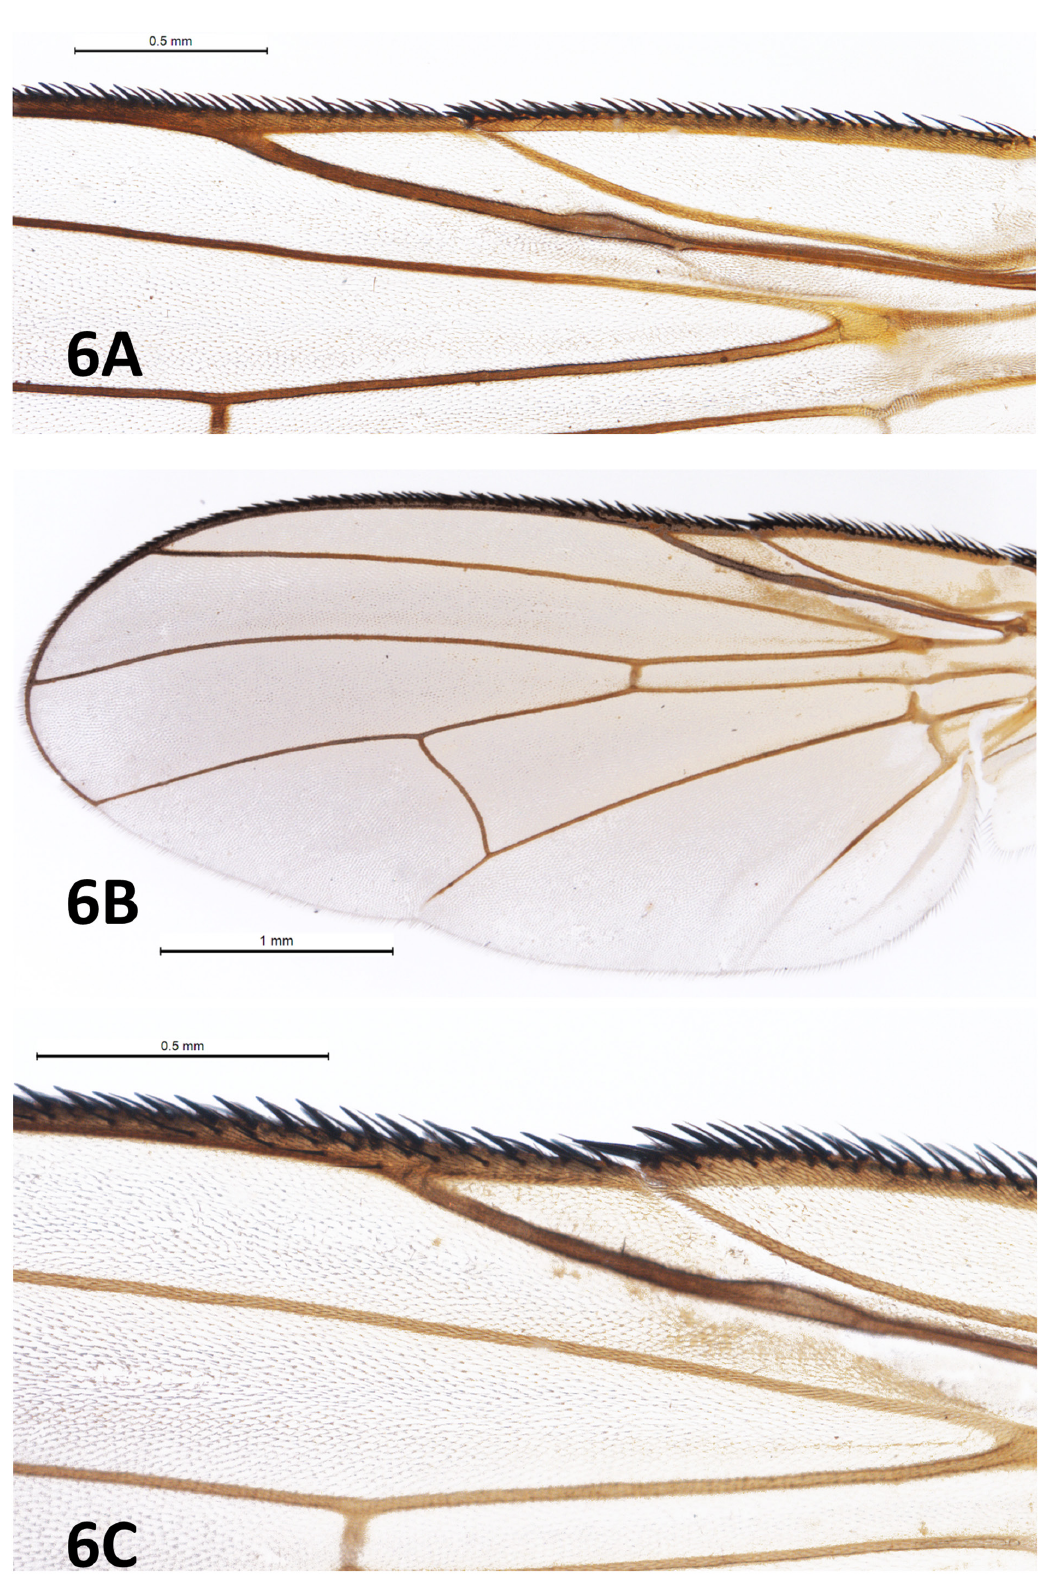
Fig. 6. ♀♀ of Drymeia Meigen, 1826. A . D . vicana (Harris, 1780), detail of wing showing CS1‒3, ventral view. B . D . hamata (Fallén, 1823), wing, ventral view. C . Same, detail of wing showing CS1‒3, ventral